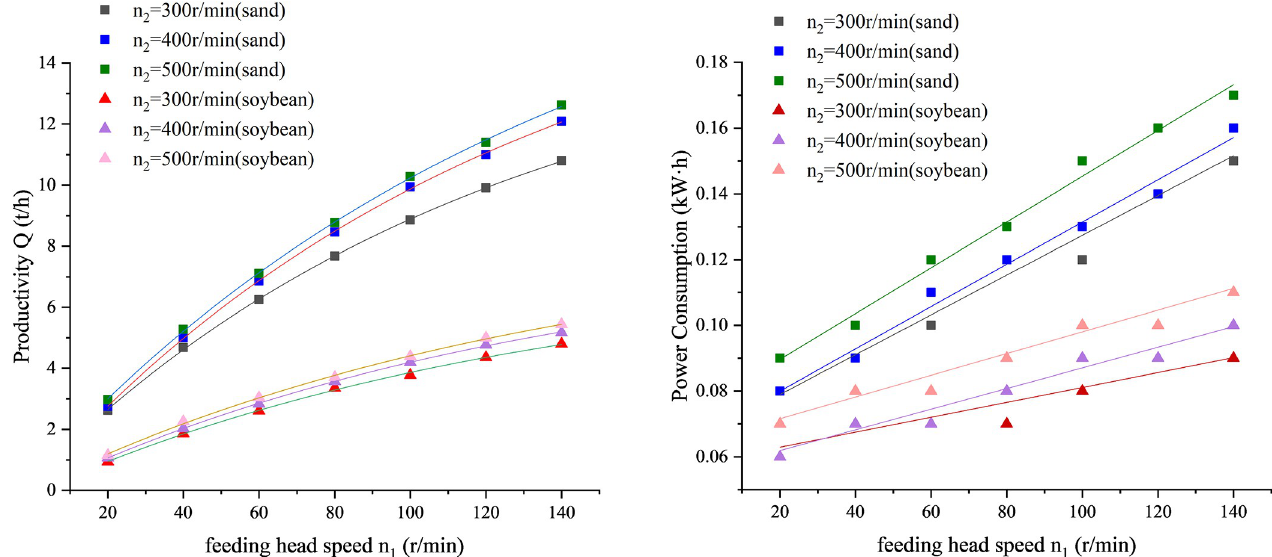
Fig 6. Curve of productivity and power consumption versus screw speed n 1 . (A) Productivity. (B) Power consumption.